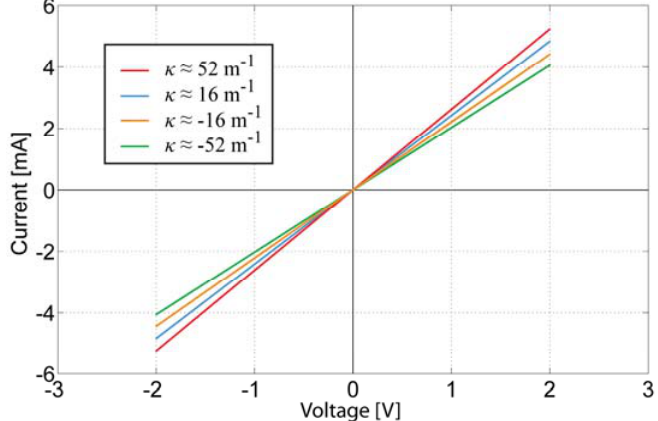
Figure 13. Voltammogram of a CDC-based electrode for different material